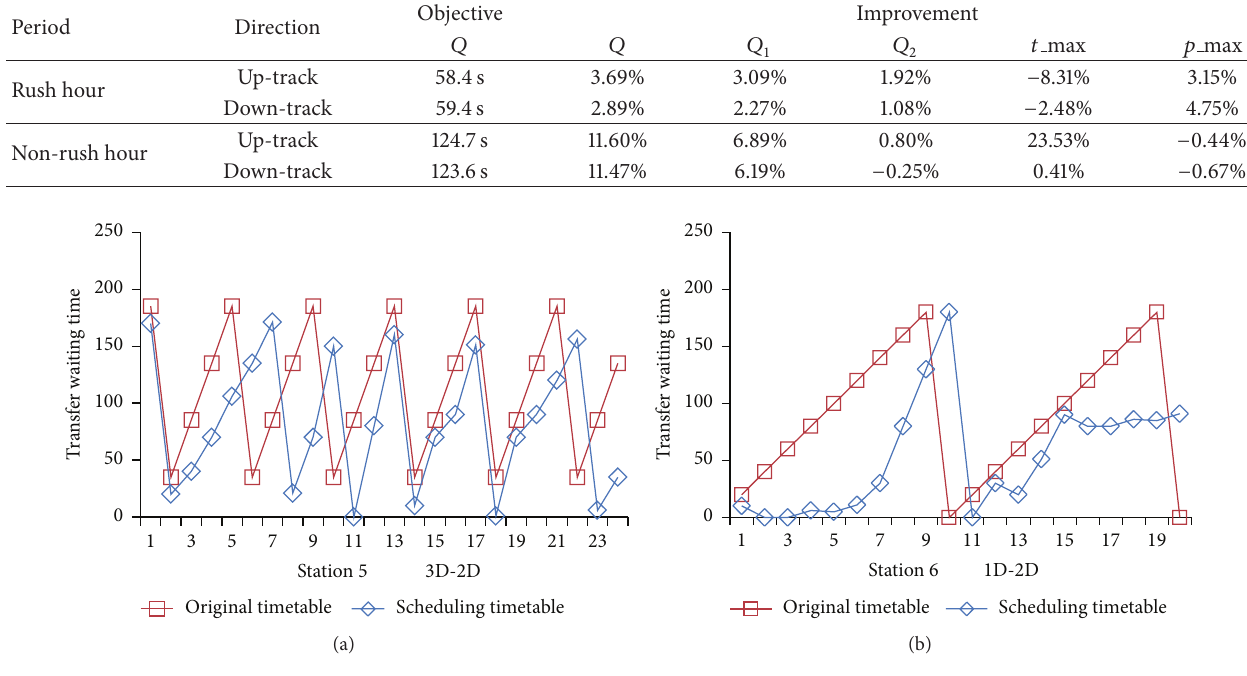
Figure 8: Transfer waiting time from all feeder trains at the transfer station.